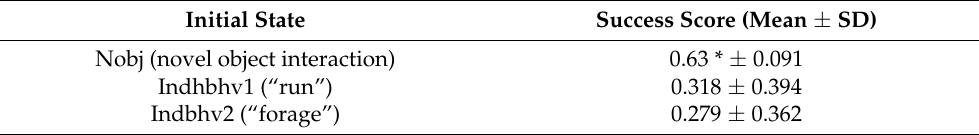
Figure 3. Markov chains representing the probabilities of transition in behavioural state: ( a ) behav- ioural chain after novel object interaction; ( b ) behavioural chain after individual behaviour “run”; ( c ) behavioural chain after individual behaviour “forage”. Only transitions within the behavioural chain are represented; values are percentages. Behavioural states are defined in Table 4. Initial be- haviours are defined in Table 3. Table 6. Initial state and success score of Markov chain calculation ( n = 24).